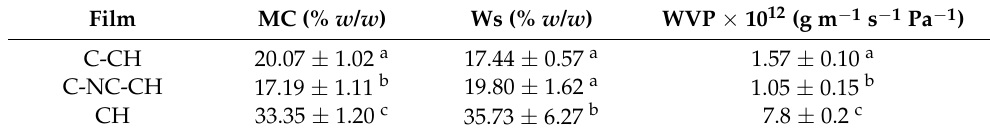
Table 1. Films’ physical